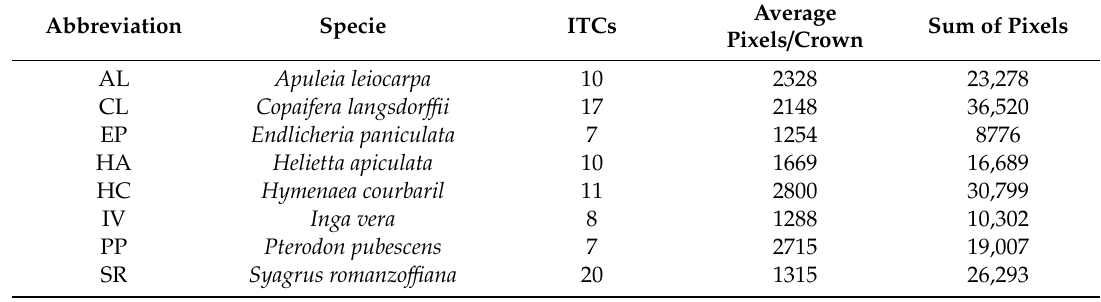
Table 1. The number of samples recognized in the field and the average number of pixels per crown for each tree species and its sum.